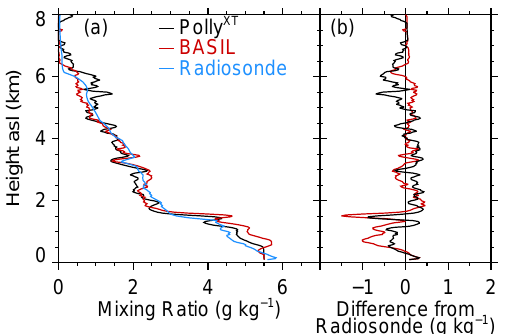
Figure 8. Statistical analysis of lidar profiles determined by the IWV method: (a) Absolute bias between the radiosonde (RS) and Polly XT (black), RS and Polly XT calibrated with a constant calibra- tion factor of 12.4 (blue), between RS and BASIL (red) and between Polly XT and BASIL (green). (b) Root-mean-square error (RMSE) of the water vapour mixing ratio. The numbers indicate the sample